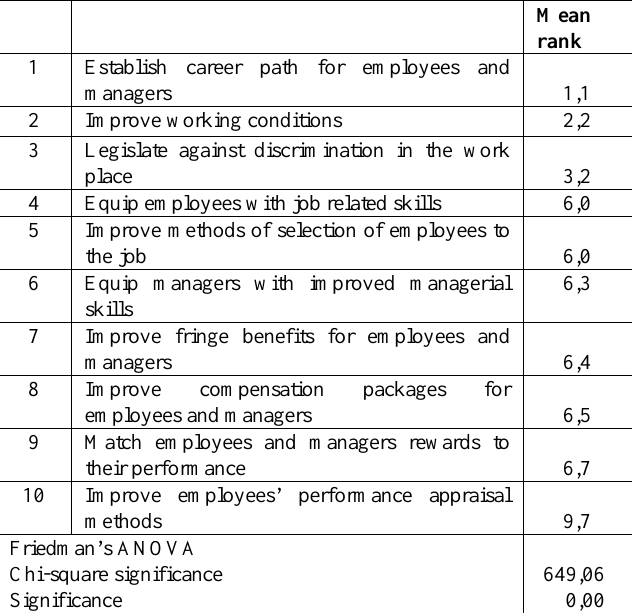
Table 7: Desired human resource